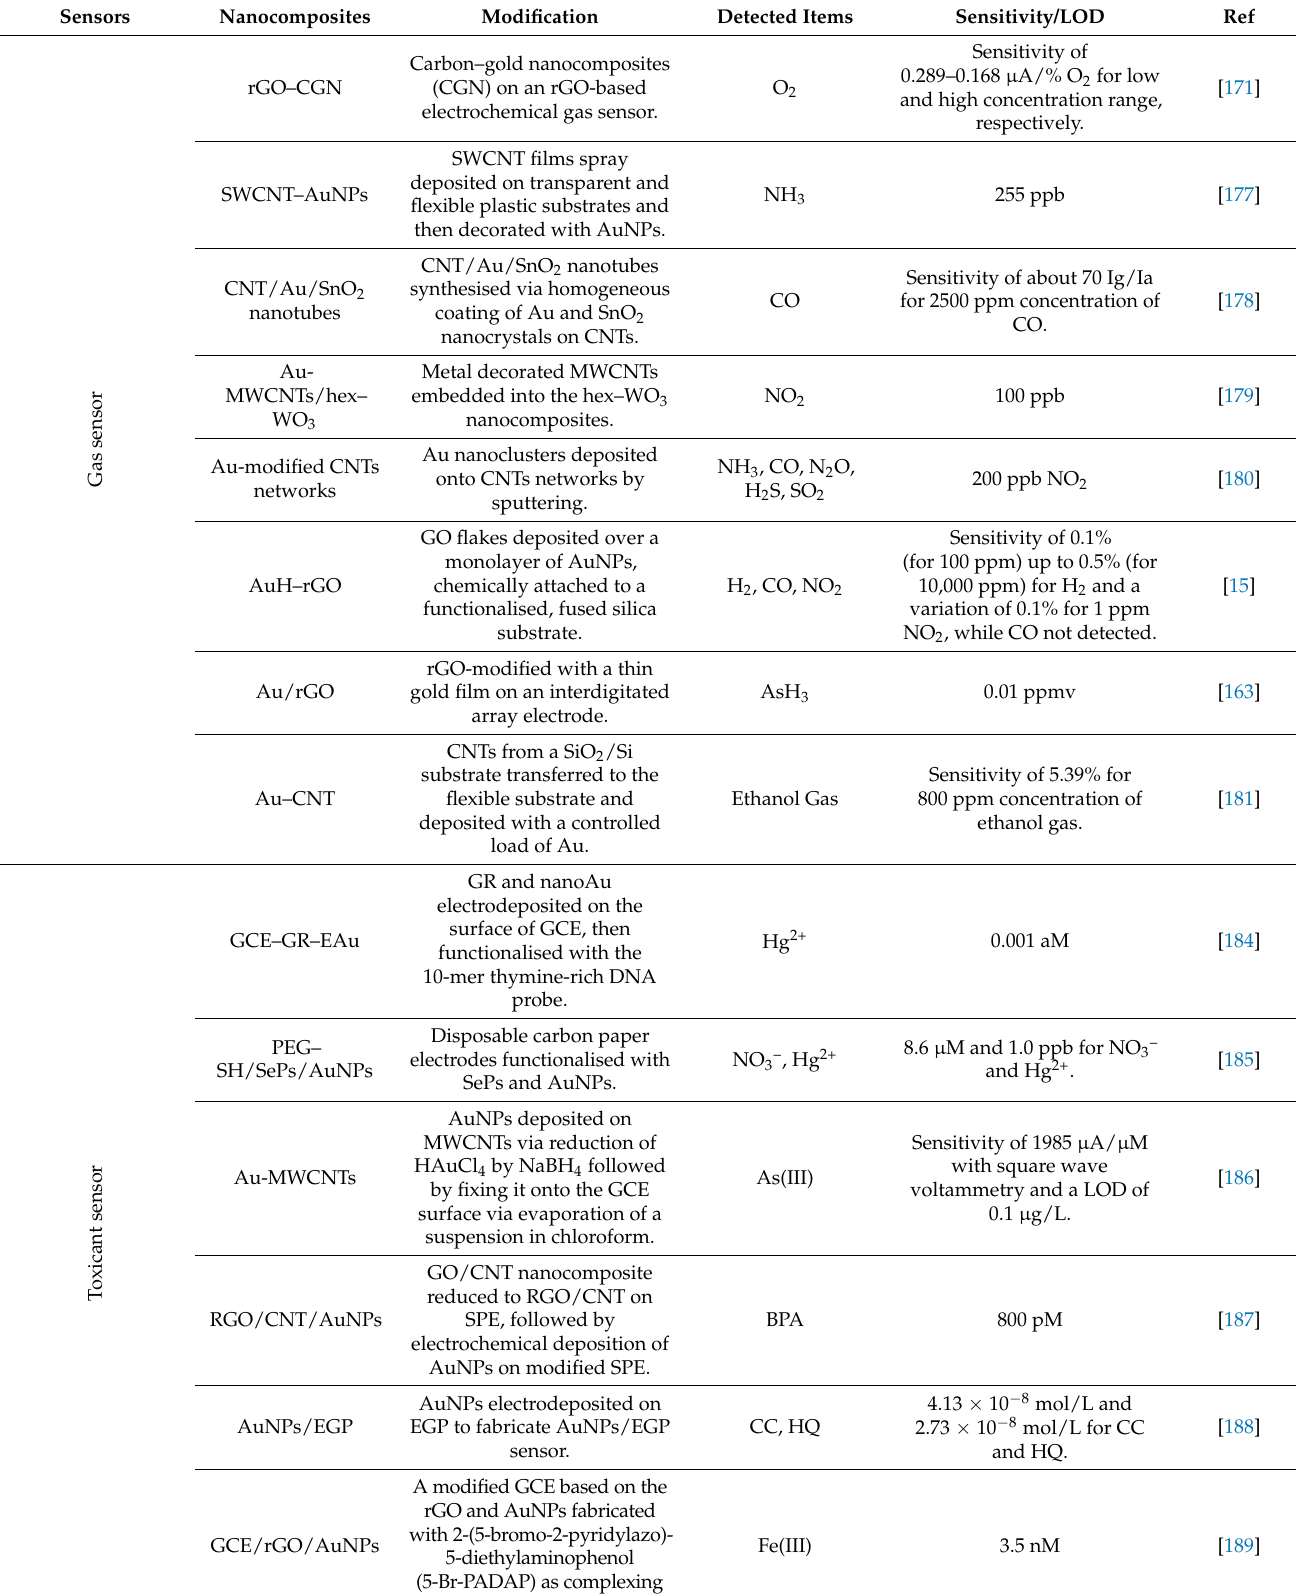
Table 1. Sensitivity/LOD comparison of the reviewed nanocomposites sensing